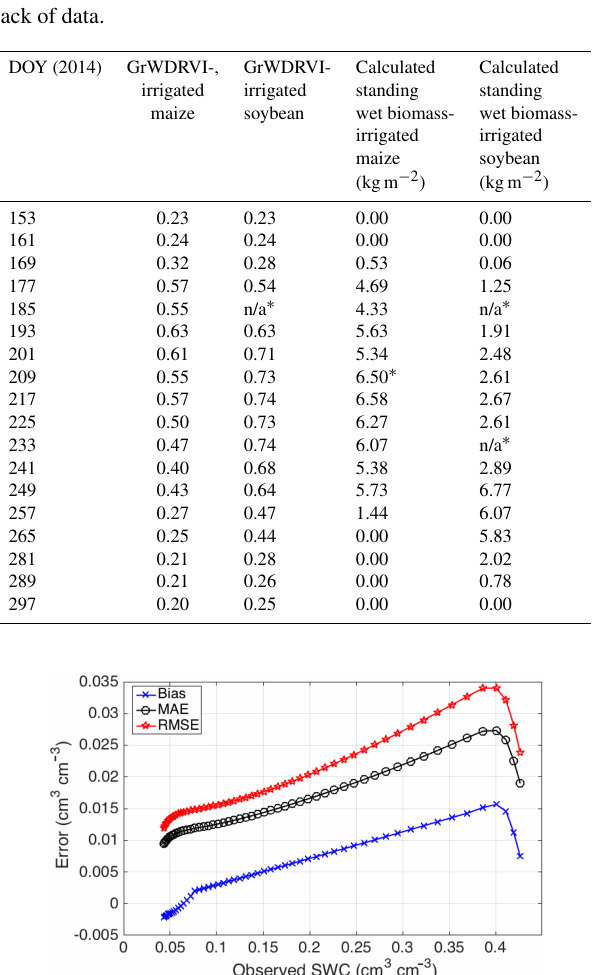
Table 4. Summary of 2014 observed standing wet biomass for irri- gated maize and irrigated soybean fields near Waco, NE. The obser- vations represent the aggregation of 18 plants collected at 6 different locations across the field on the sampling date. DOY (2014), Observed